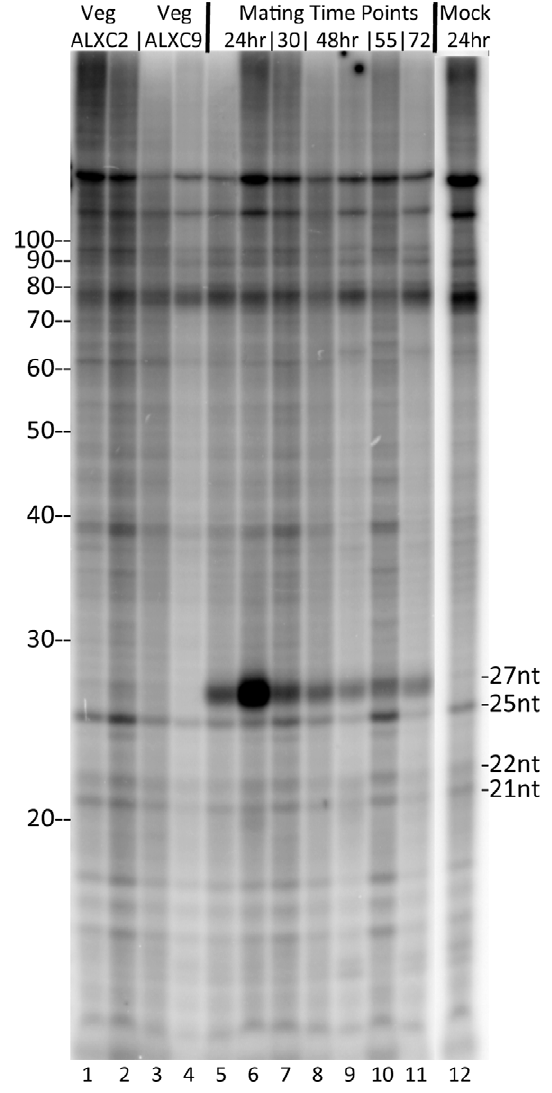
Figure 1. Mating in Oxytrichatrifallax leads to production of a class of 27 nt RNAs. Total RNA was purified from vegetative Oxytricha trifallax (lanes 1–4) or at various time points after mixing together complementary mating strains (lanes 5–11). In addition, total RNA was purified from strain ALXC9 treated under identical conditions as a mating for 24 hrs (lane 12 - Mock 24hr). Total RNA was phosphatase treated followed by 5 9 end labeling with 32 P, separated on a 15% polyacrylamide denaturing gel and visualized using a PhosphorImager. Sizes from Decade RNA 10 nt Ladder (Ambion) are indicated at left. Positions of small RNAs of interest are indicated at right. Lanes 1–11 directly correspond to RNA preparations used to prepare libraries for Illumina sequencing listed in the same order in Table 1.